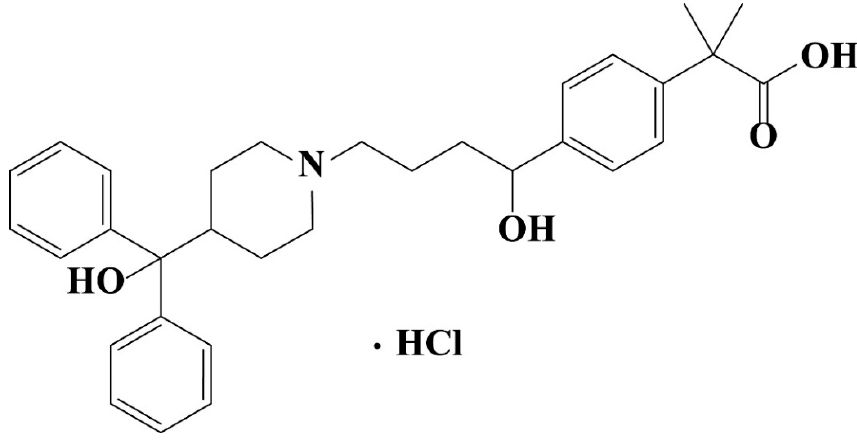
Figure 1. Chemical structure of fexofenadine hydrochloride (FXD). Table 1. The list of ready ‐ to ‐ use excipients.